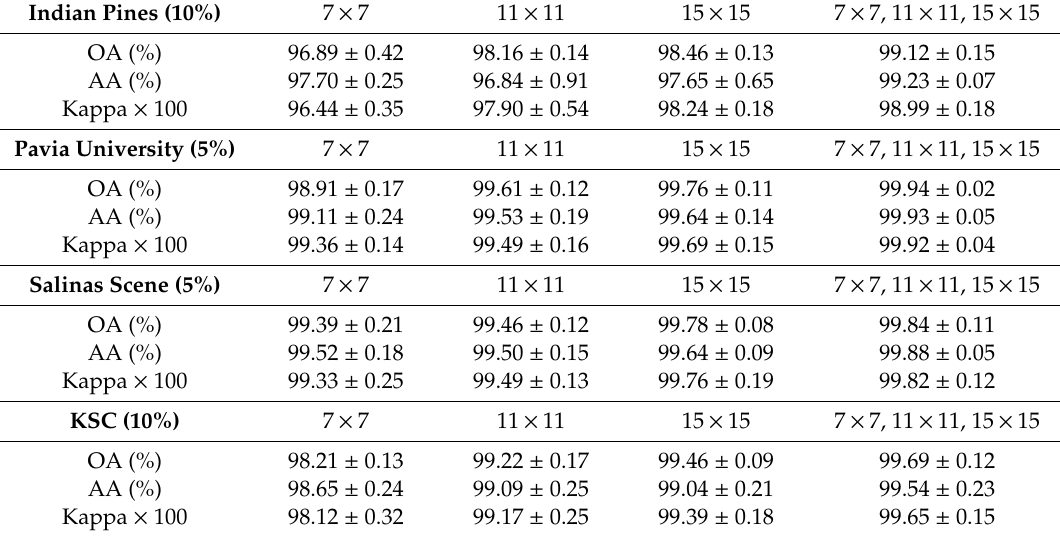
Table 2. The results of di ff erent scales on di ff erent data sets. Data are given as mean ± standard deviation. Legend: OA, overall accuracy; AA, average